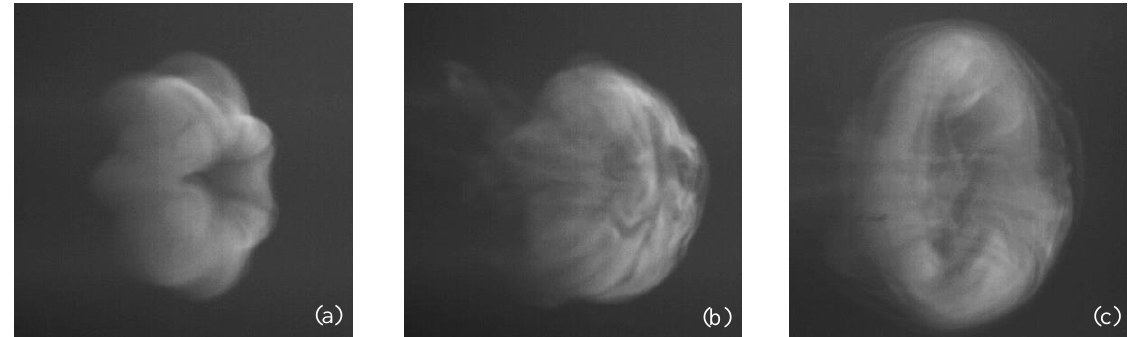
Fig. 3 Visualization of vortex rings without swirl in case B: (a) azimuthal wavy deformation, (b) turbulent state, (c) laminar state.